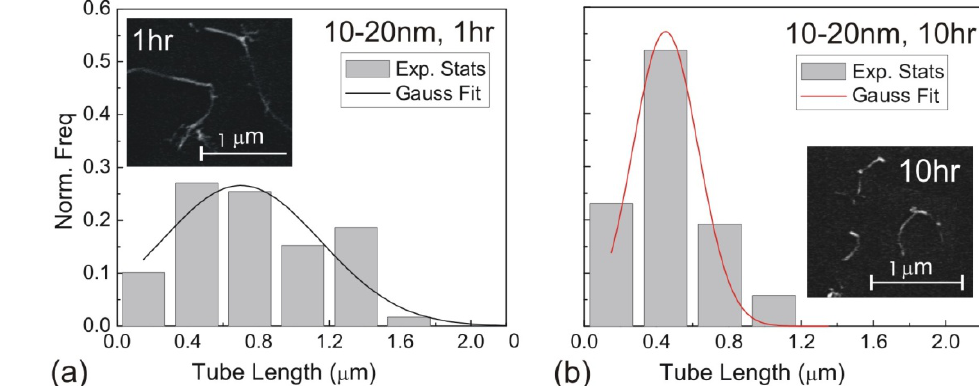
Figure 2. Histogram of length distribution for d = 10–20 nm MWNTs after the ( a ) 1 h, and ( b ) 10 h horn sonication treatment. Gaussian profiles are fitted to both histograms for better statistical analysis. The corresponding SEM images of the MWNTs after sonication treatment are shown as